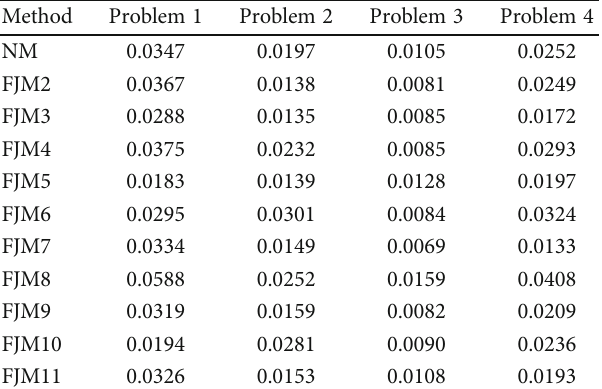
Table 11: Values of FJC1 for case n = 500